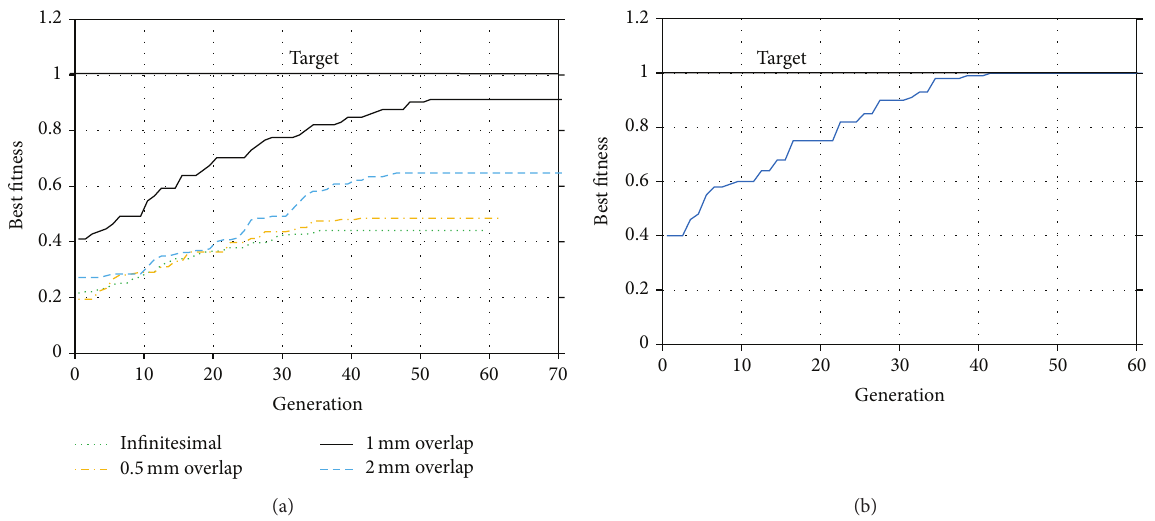
Figure 7: Best fitness over generations. (a) For infinitesimal connections and uniform overlaps. (b) For nonuniform overlaps.